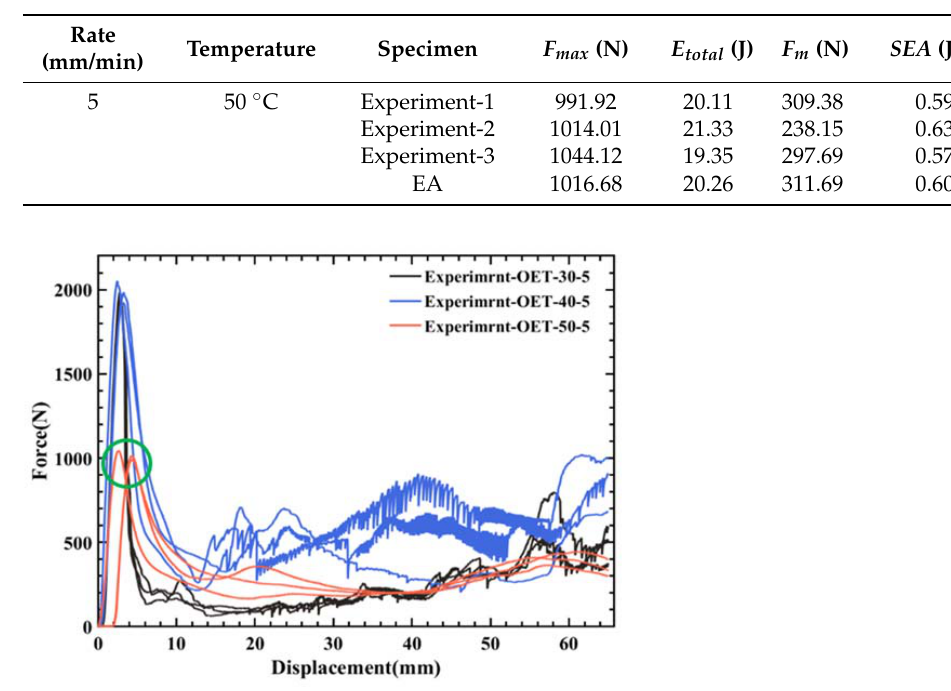
Table 6. The compression rate at 5 mm/min: the energy absorption index of quasi-static uniaxial compression experiment and numerical simulation of OET at 50 ◦ C.